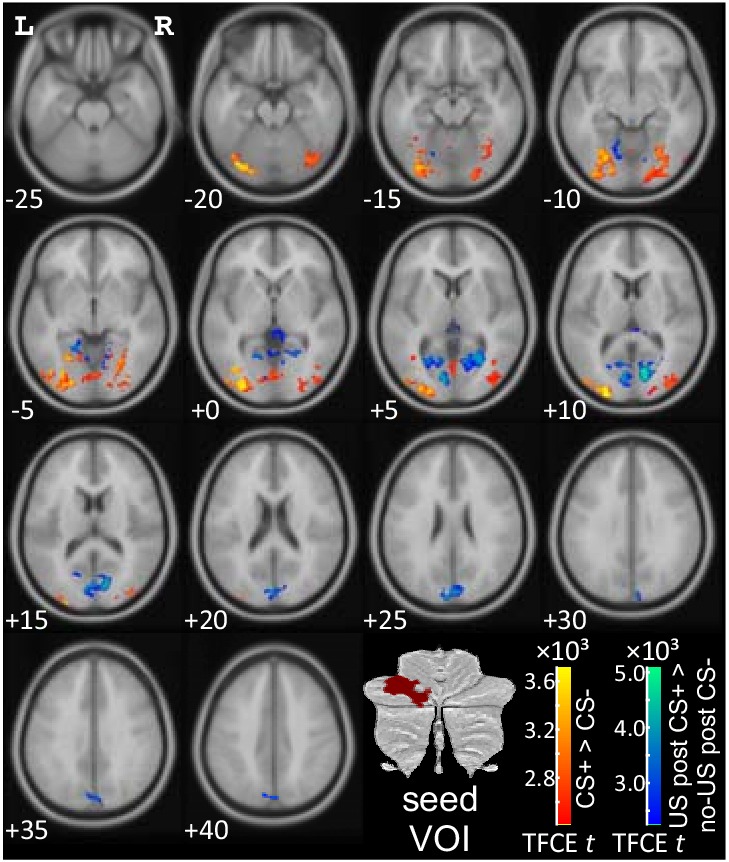
PPI analysis based on a seed region in the left lateral cerebellar cerebellum (p<0.05 FWE corrected level after TFCE application).CS = conditioned stimulus; FWE = familywise error; L = left; PPI = psychophysiological interaction; R = right; TFCE = threshold-free cluster-enhancement; US = unconditioned stimulus; VOI = volumes of interest.